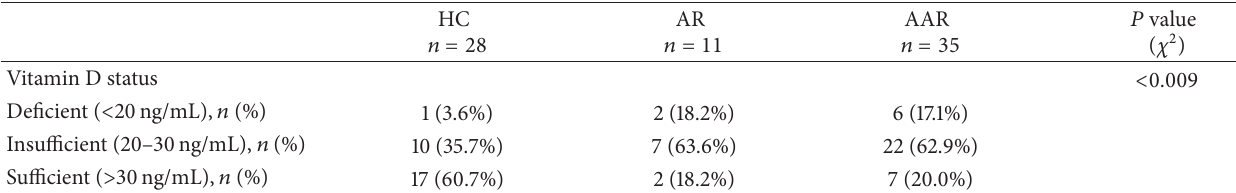
Table 2: Frequency distribution of vitamin D status classes among HC, AR, and AAR